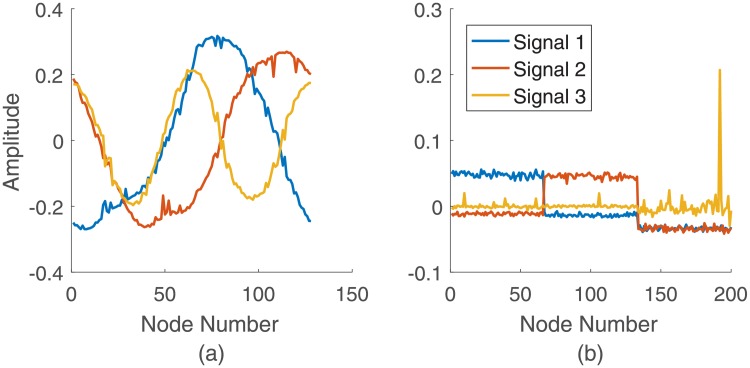
Signal representation of weighted network.First three signals from a. A weighted small-world network with K = 6, and N = 128 nodes; b. A weighted stochastic block network with probability of attachment p = 0.3, and N = 200 nodes.